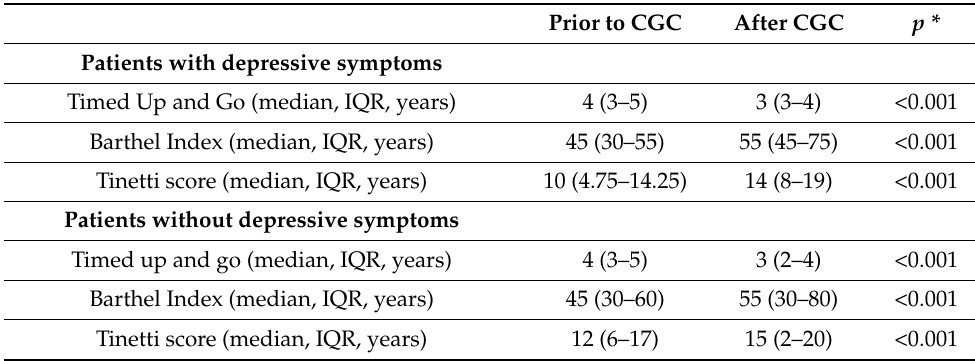
Table 2. Timed Up and Go test, Tinetti score, and Barthel Index scores; values for geriatric patients with and without depressive symptoms prior to versus after comprehensive geriatric care (CGC).